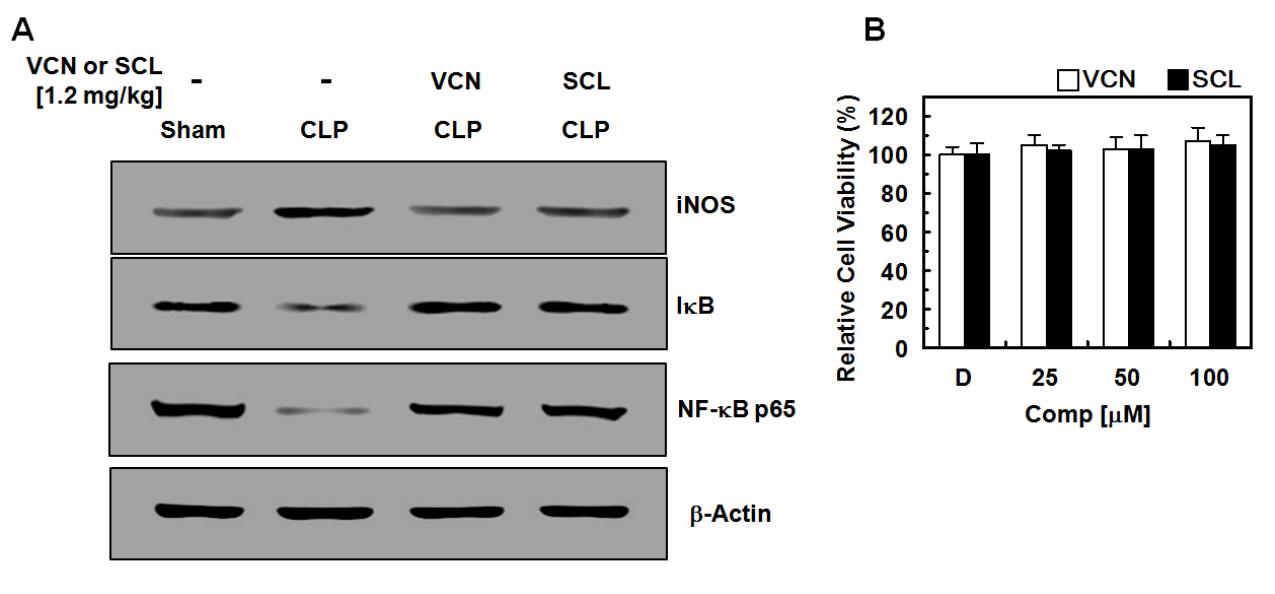
FIGURE 1 - Effects of vicenin-2 (VCN) and scolymoside (SCL) treatment on renal inducible nitric oxide synthase (iNOS), inhibitor of kappa B (I κ B), and nuclear factor-kappa B (NF- κ B) expression in cecal ligation and puncture (CLP)-operated mice. (A) Sham-operated mice; CLP-operated mice; mice treated with VCN or SCL (1.2 mg/kg body weight) 12 h and 50 h after CLP surgery (from left line). Western blots of iNOS, I κ B, NF- κ B, and b -actin. The image is representative of results obtained from three different experiments. (B) The effects of VCN and SCL on cellular viability were measured via MTT assay. D = 0.2% dimethyl sulfoxide (DMSO), used as the vehicle control. The results are shown as means ± SD from three separate experiments on different days performed in